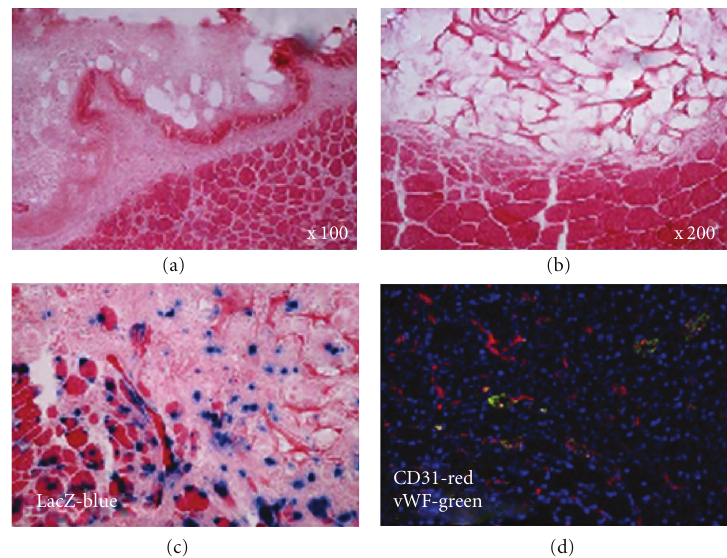
Figure 3: The immunocompatibility of the sca ff olds was examined in normal mice and SCID mice in vivo . Twenty days after implantation in the normal mouse model, nonseeded sca ff olds were rejected by the host tissue (a). Twenty days after implantation in the SCID mouse model, nonseeded sca ff olds were not rejected by the host tissue, and few host cells migrated into the sca ff old (b). Twenty days after implantation in the SCID mouse model, LacZ-labeled C2C12 myoblast seeded sca ff olds were well received in the host tissue (c). Also, LacZ + cells were able to migrate into the surrounding host tissue. An immunofluorescent staining of CD31 ( red ) and vWF ( green ) was performed on the implanted seeded sca ff olds 20 days after implantation